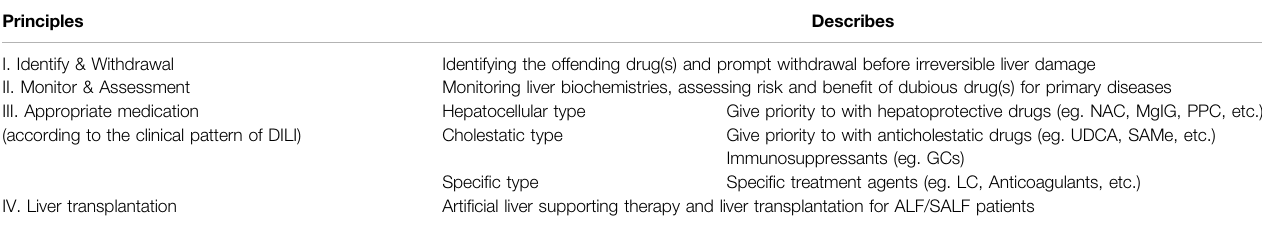
TABLE 1 | Basal principles of DILI management. Principles